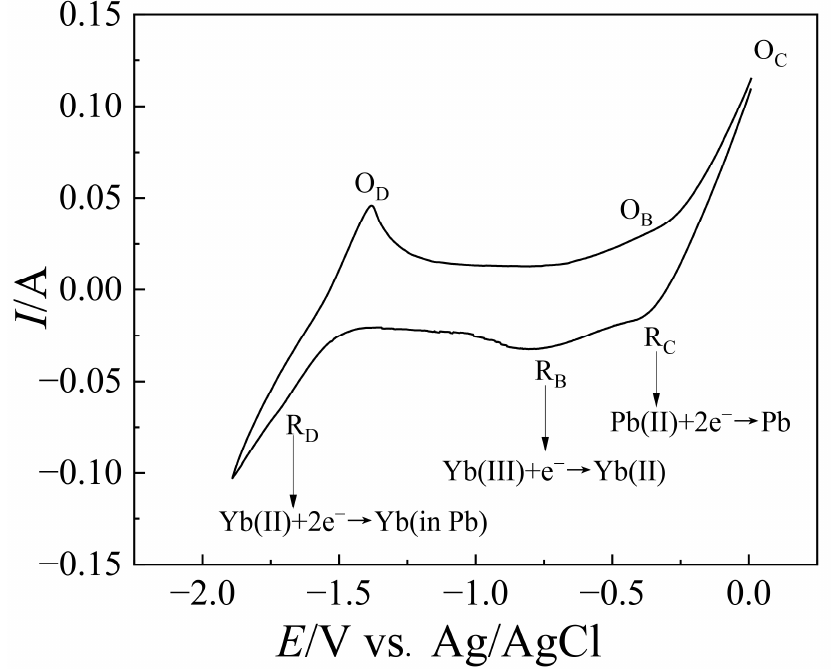
Figure 10. CVs obtained in LiCl-KCl-YbCl 3 (1.55 × 10 − 4 mol cm − 3 ) melt on liquid Pb cathodes ( S = 0.949 cm 2 ) at 773 K.